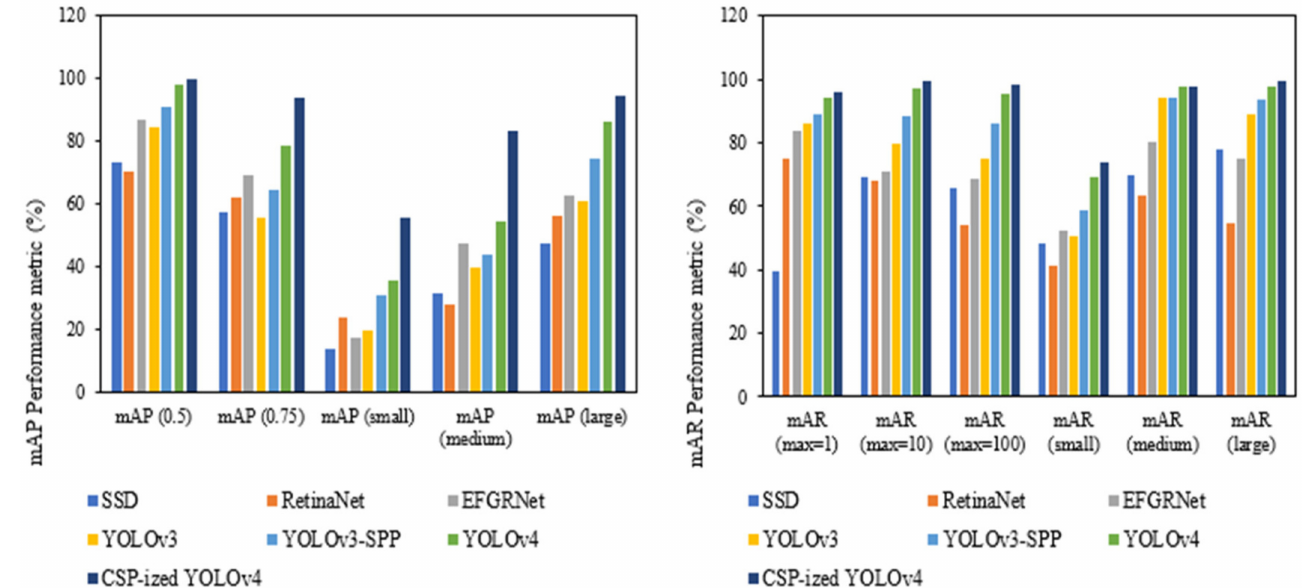
Figure 10. The graphic depiction of the best testing performance by COCO evaluation metrics at varying mAP and mAR